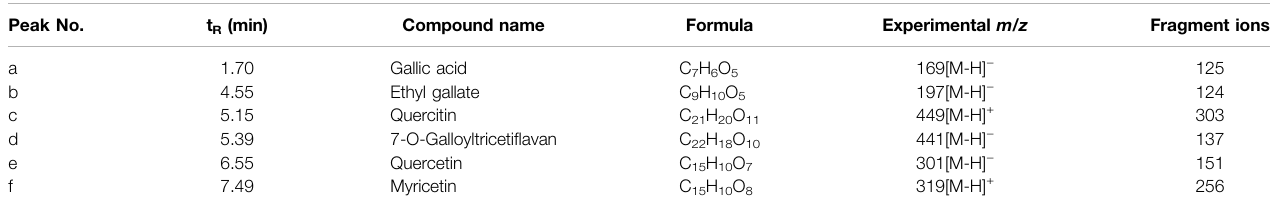
TABLE 1 | Representative LC/MS/MS data of primary active constituents identi fi ed in ESW from P. clypearia . Peak